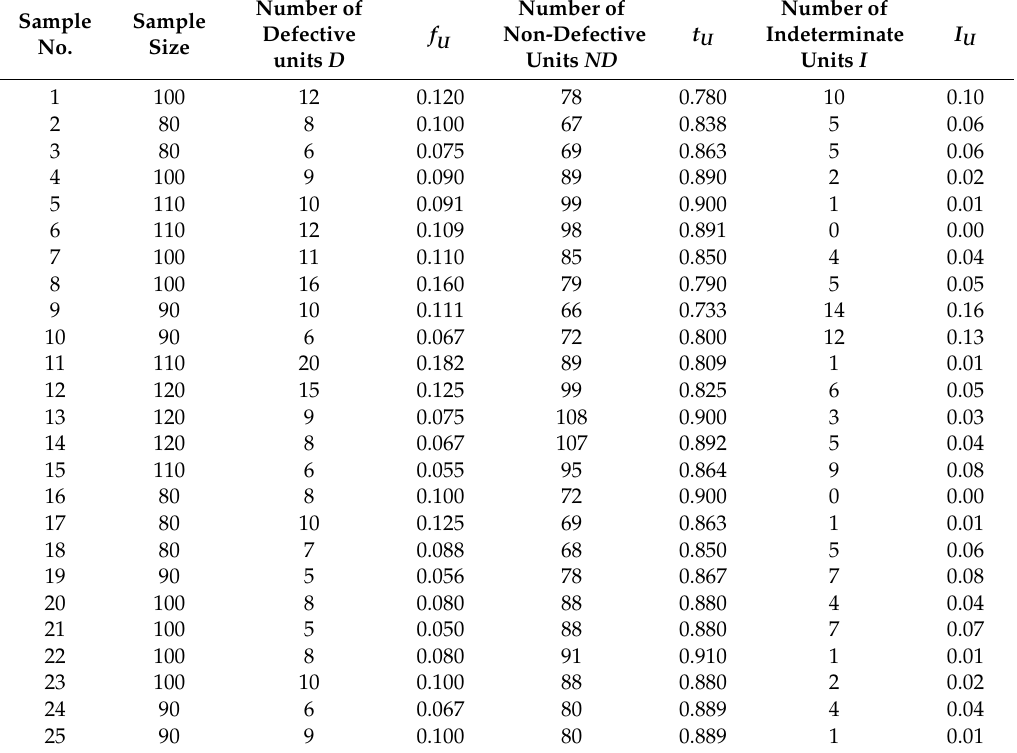
Table 3. Neutrosophic data with variable sample size.